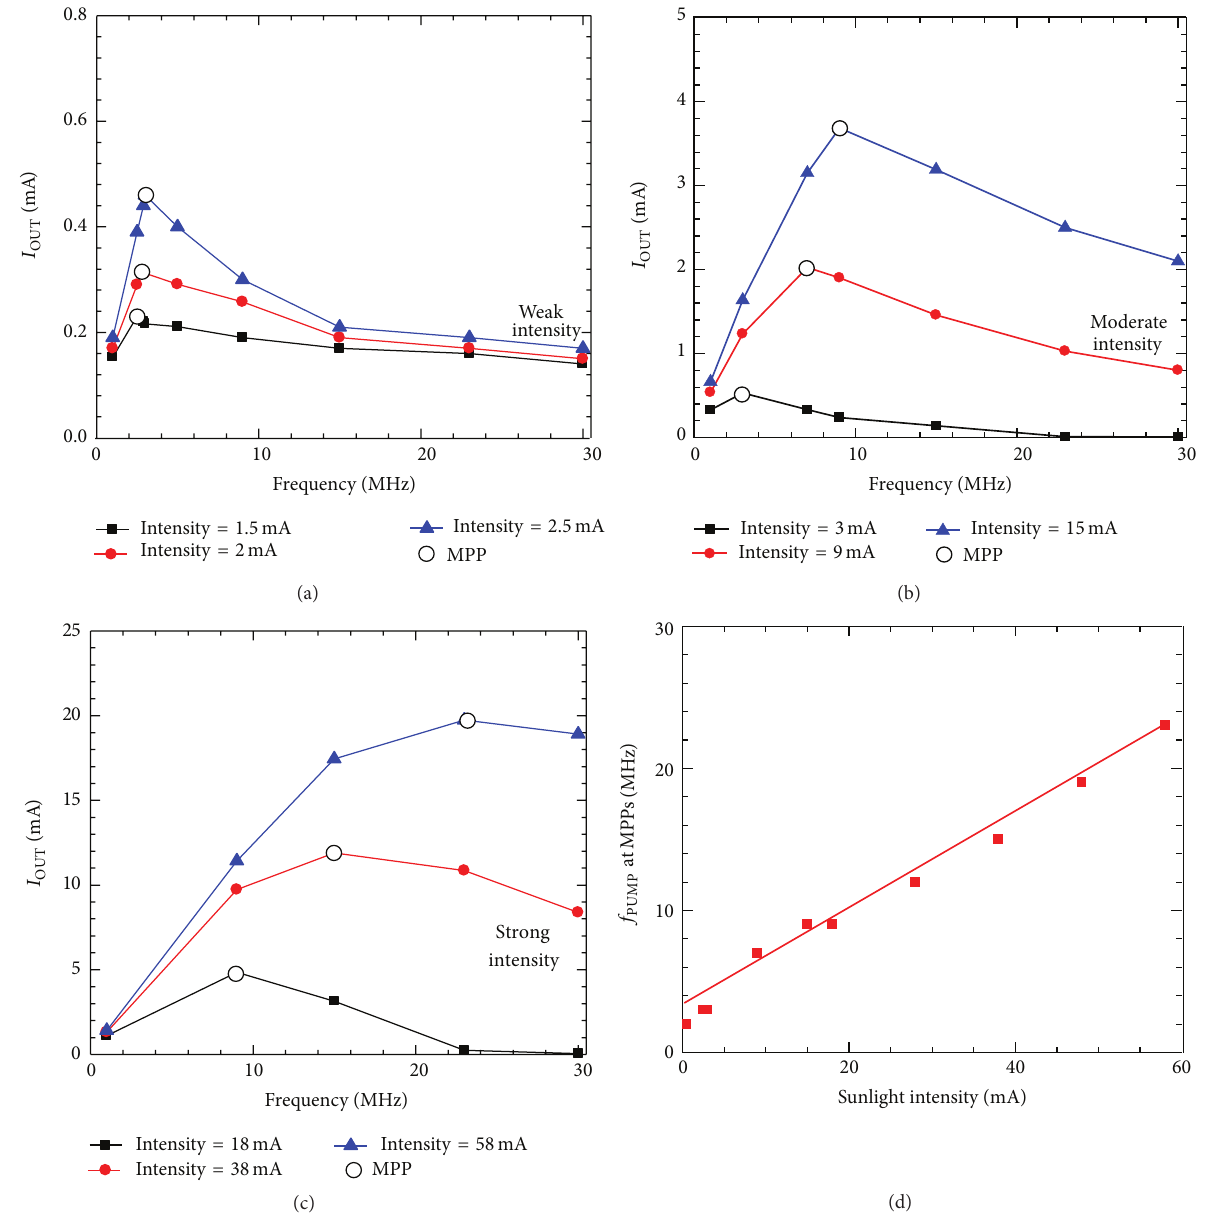
Figure 3: (a) Output current of RCP circuit in weak sunlight intensities with varying pumping frequency. (b) Output current in moderate sunlight with varying pumping frequency. (c) Output current in strong sunlight with varying pumping frequency. (d) The pumping frequencies at MPPs with varying sunlight intensity from 1.5 mA to 58